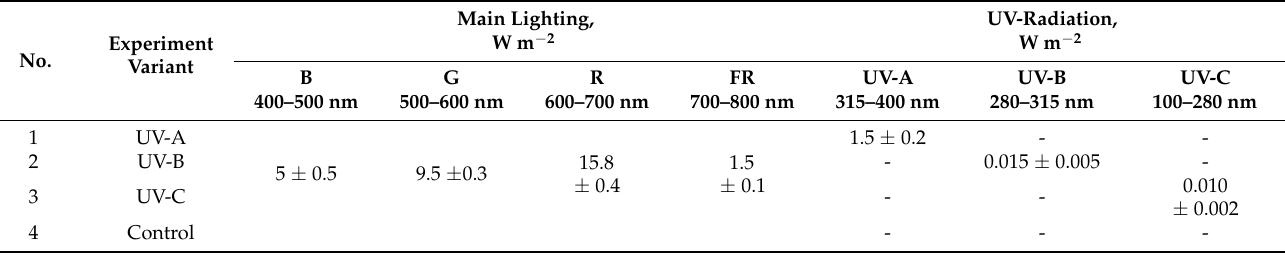
Table 1. Spectral properties of radiation sources.